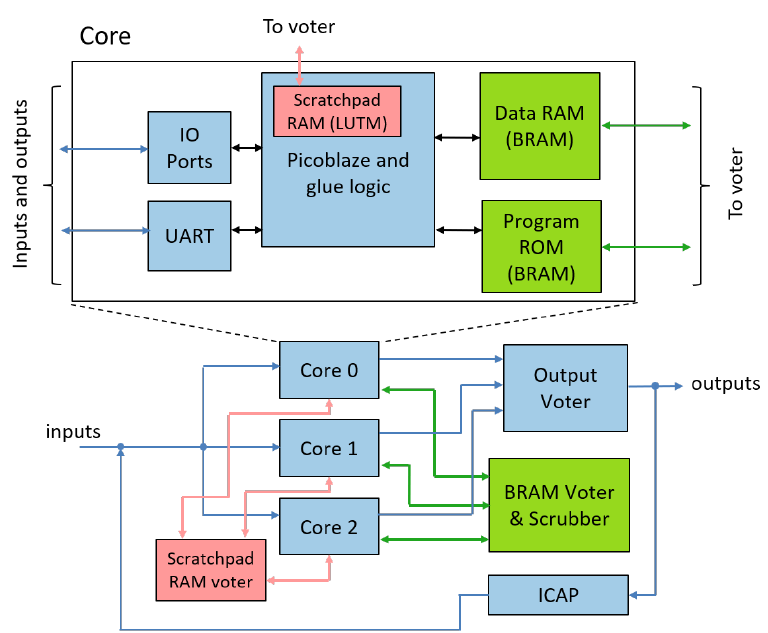
Figure 2. Simplified block diagram of the scrubber architecture.